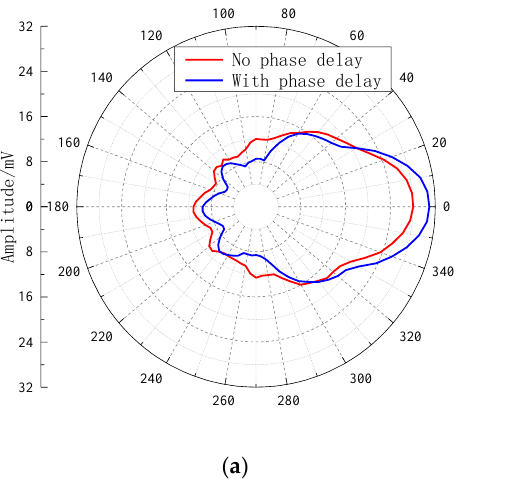
Figure 16. Horizontal directivity curves of the acoustic field radiated by the transmitting phased array. ( a ) Non-normalized curves and ( b ) normalized curves.